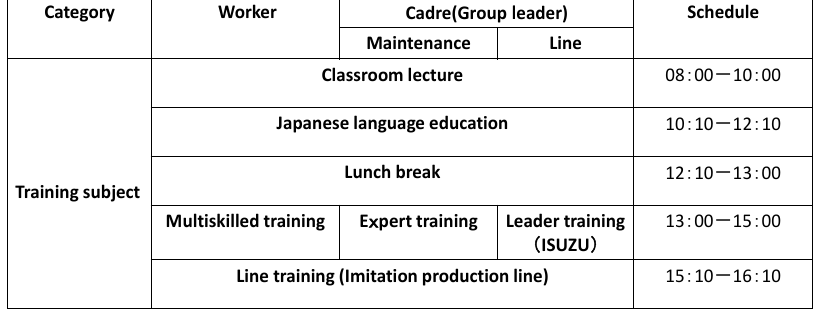
Table 4. Training plan Category